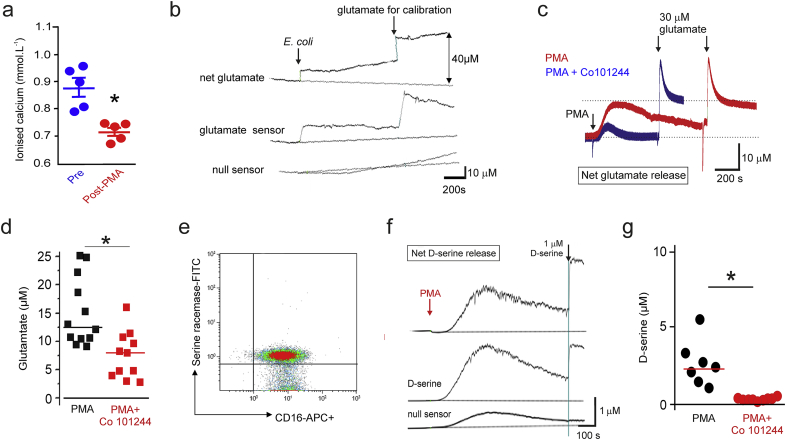
Release of glutamate and d-serine by activated human neutrophils.A) Ionised calcium falls in whole human blood after PMA stimulation; calcium levels are shown from the same blood samples before and after PMA (*p < 0.01, paired t-test, n = 5 separate samples).B) Real-time recordings of glutamate release (negative deflection) by isolated primary human neutrophils before and after application of Escherichia coli in whole blood. Glutamate biosensor was calibrated with 40 μM glutamate at the end of the experiment. The null sensor, which lacks enzymes, detects release of non-specific electroactive species. The difference between glutamate and null sensor readings quantifies glutamate.C) Real-time recordings of glutamate release by isolated primary human neutrophils before and after application of PMA. PMA-induced glutamate release was reduced in the presence of Co 101244 (100 μM). Glutamate biosensors were calibrated with 30 μM glutamate at the end of the experiment. The null sensor detects non-specific interferents.D) Summary data for glutamate release from isolated primary human neutrophils following PMA-activation in the presence/absence of Co 101244 (100 μM; n = 10 separate samples; * p < 0.05, by paired t-test).E) Density plot showing that serine racemase is present on cell surface of CD16+ primary human neutrophils. Superimposed lines show FMO/isotype control defined boundaries.F) Real-time recording of d-serine release by isolated primary human neutrophils before and after application of PMA. d-serine biosensors were calibrated with 1 μM d-serine at the end of the experiment.G) Summary data for d-serine release from isolated primary human neutrophils following PMA-activation in the presence/absence of Co 101244 (100 μM; n = 10 separate samples; * p < 0.05, paired t-test).